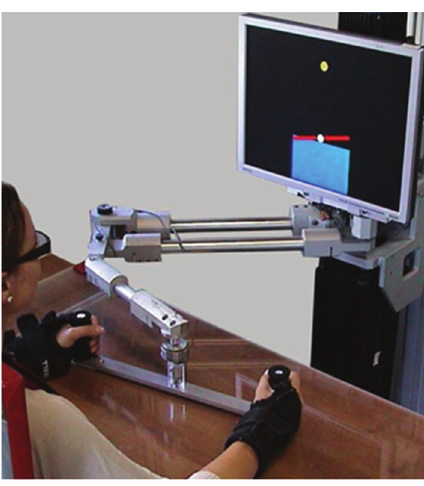
Figure 11: Braccio di Ferro. Reprinted with permission (http:// www.iit.it/).